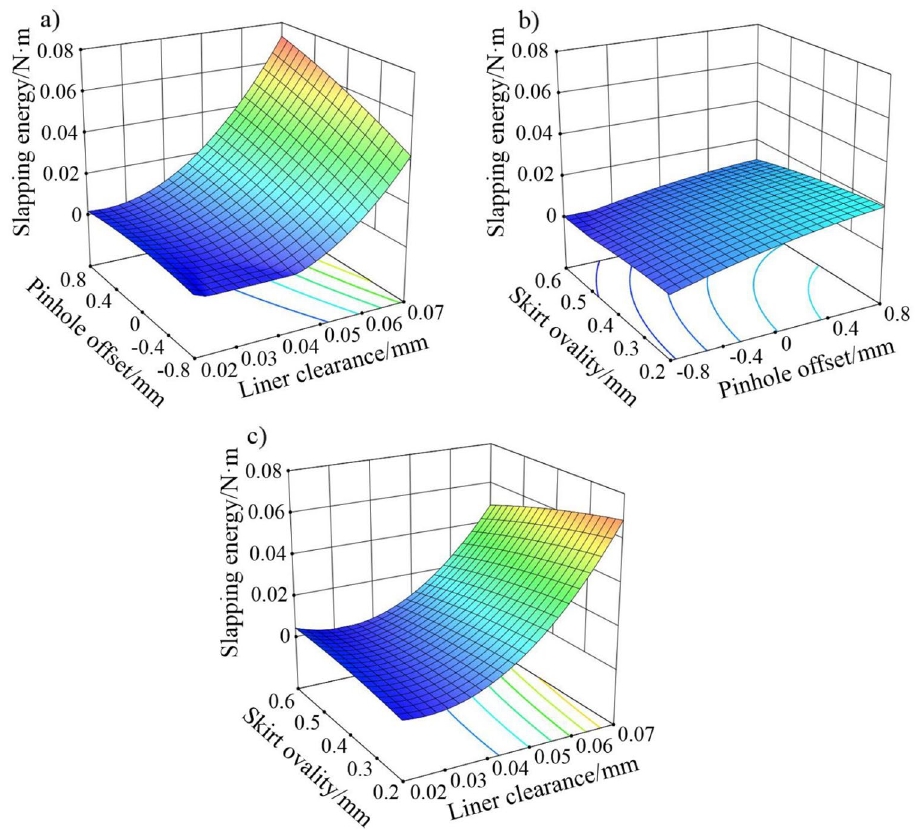
Figure 14. Response surfaces of effects on slapping energy of ( a ) pinhole offset and liner clearance, ( b ) pinhole offset and skirt ovality, and ( c ) liner clearance and skirt